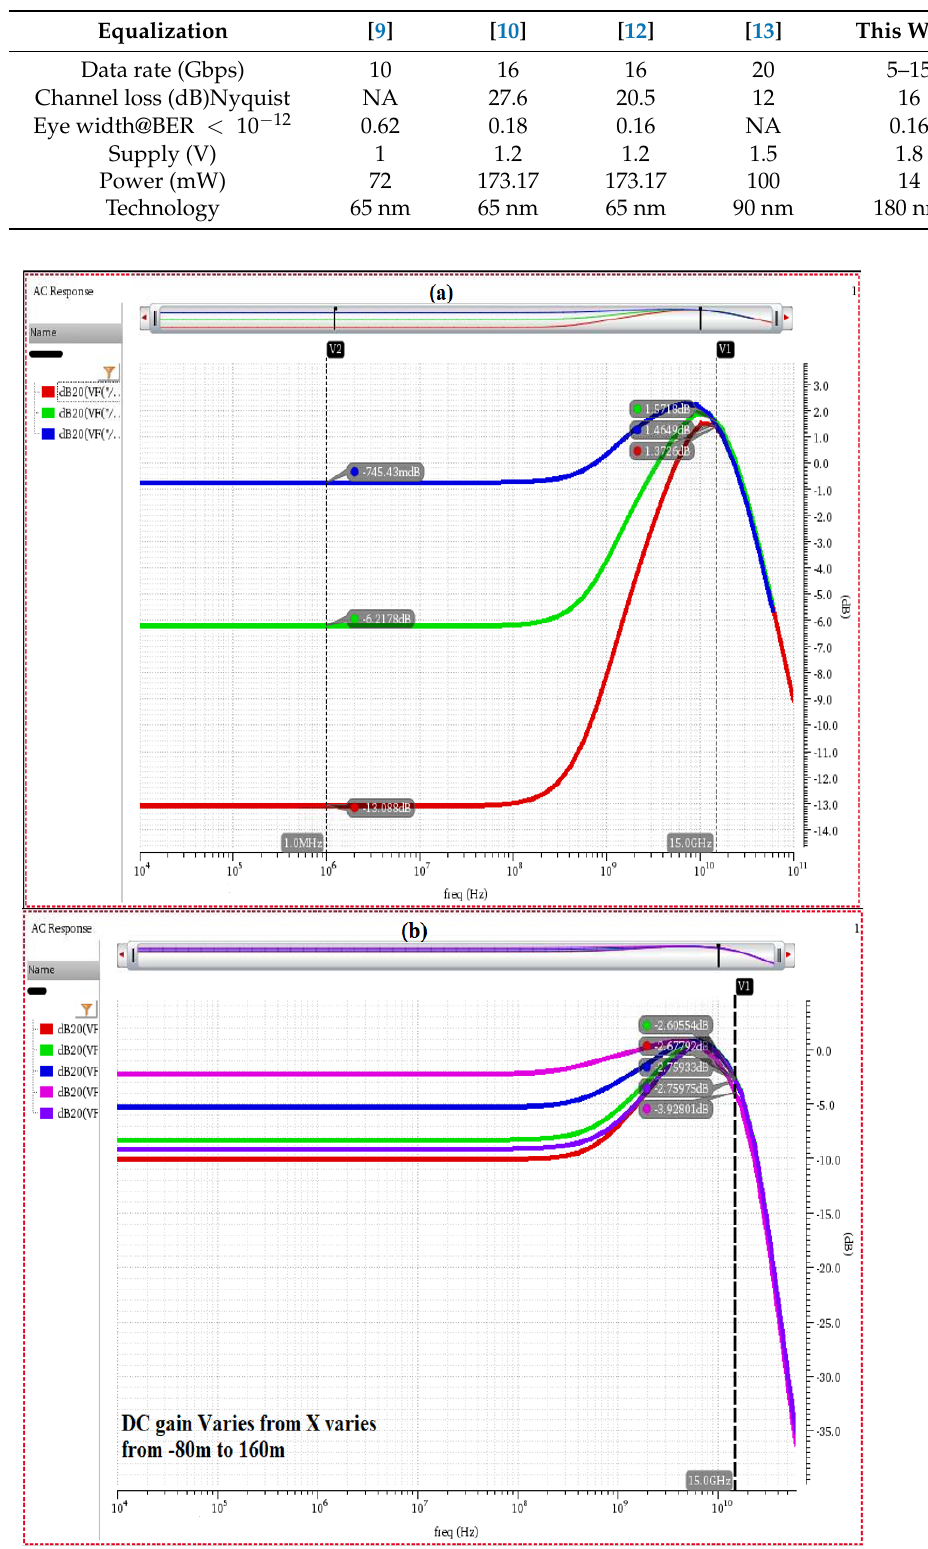
Figure 17. Simulated frequency response for the AFE. ( a ) 12 dB by tuning V bias from − 80, 0, and 80 mV and ( b ) from − 80 to 160